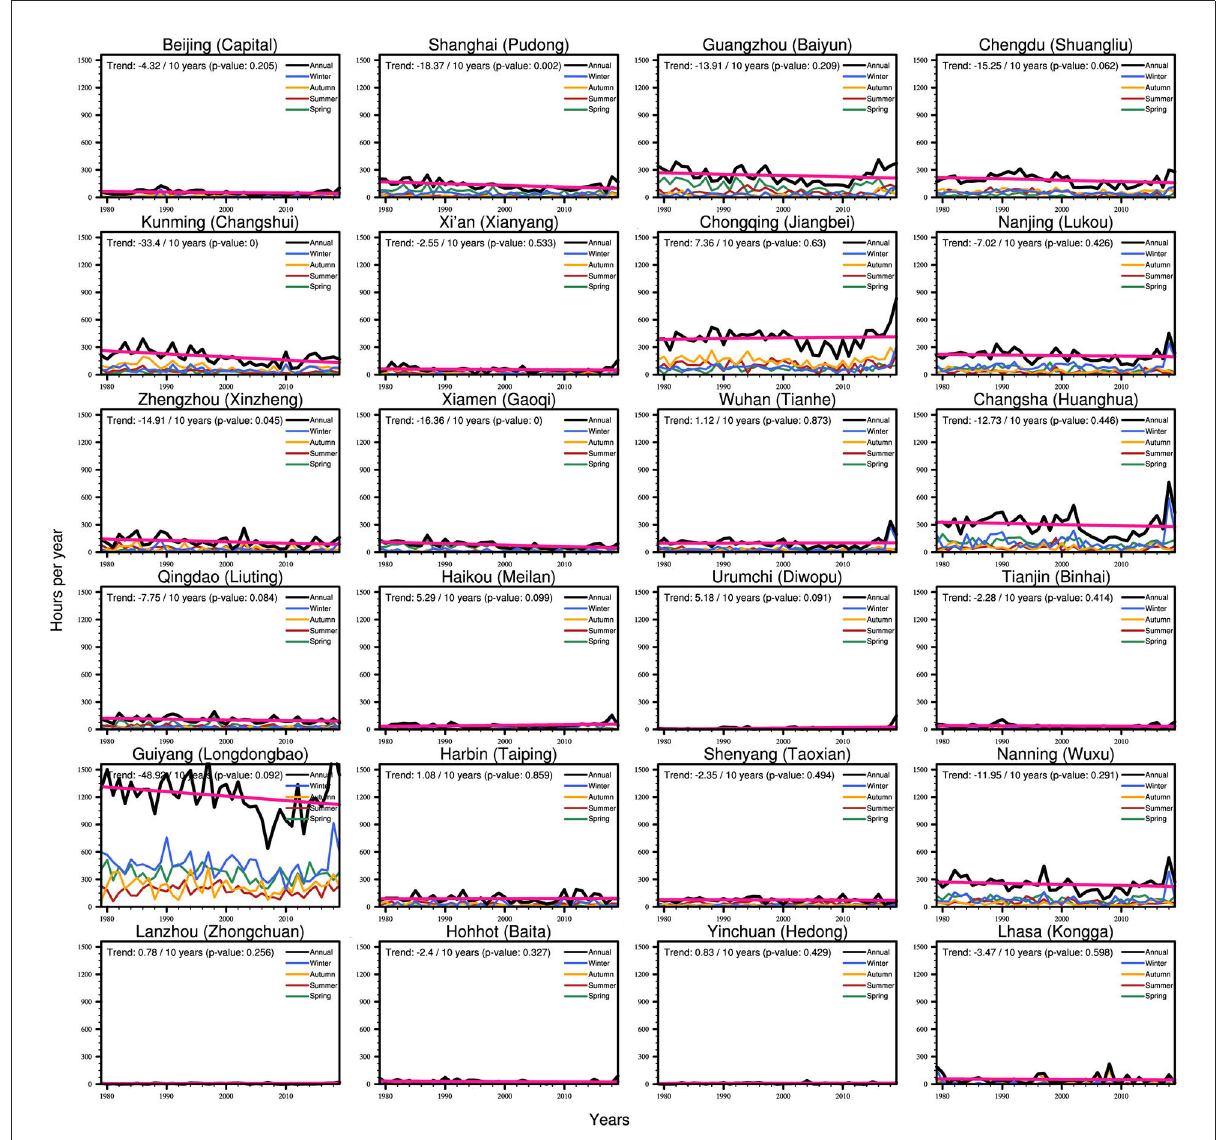
FIGURE10 Same as Figure 9, but for